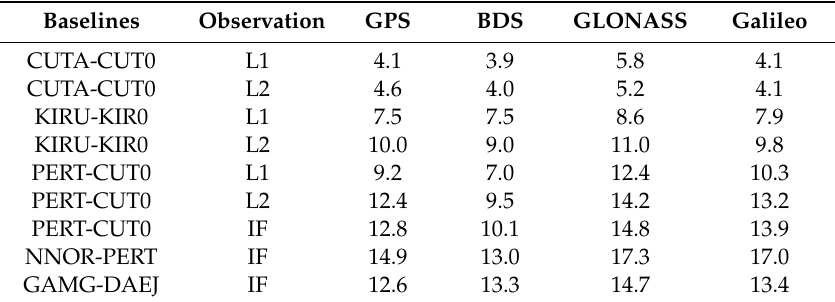
Figure 6. The posteriori residual RMS and the observation number statistics of GNSS satellites for PERT-CUT0 after solving with IF combinations on DOY 88. Table 5. Means of residual RMS for different GNSS systems (mm). Table 5. Means of residual RMS for di ff erent GNSS systems (mm).